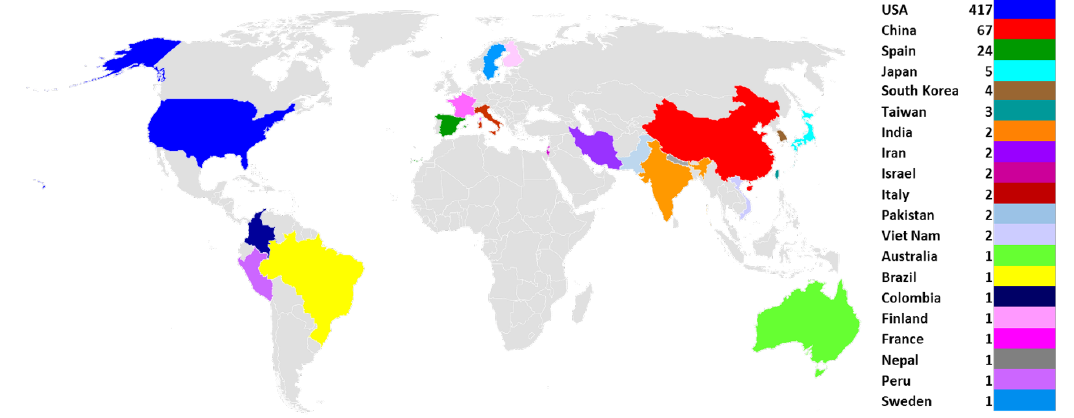
Figure 2. Distribution of SARS-CoV-2 genomes. A total of 540 genomes from 20 different countries are represented with 20 different color patterns.